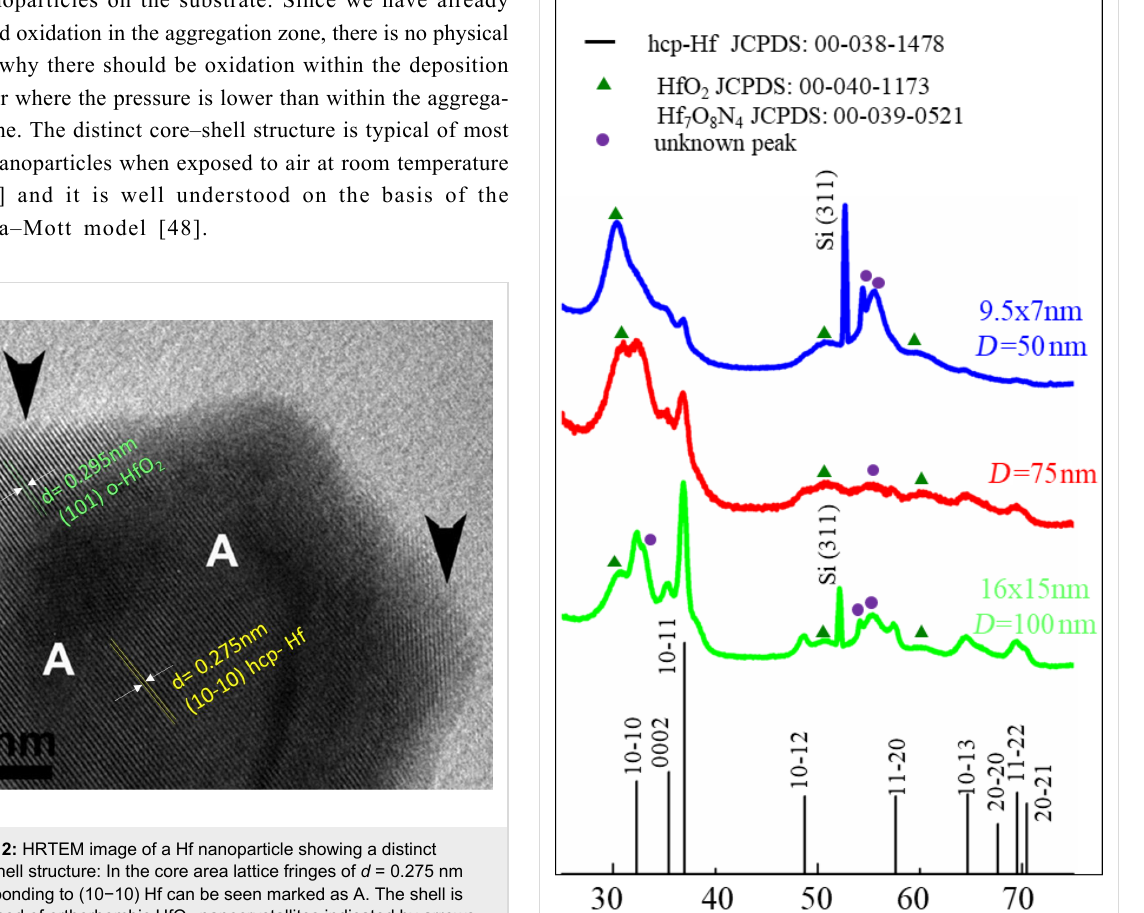
The ratio I HfO2 /I Hf of the intensities of HfO 2 at 2 θ = 30.8° and of (10 − 10) Hf at 2 θ = 36.87° is increasing with decreasing nanoparticle size. This result is due to the enhanced oxidation of smaller nanoparticles due to their higher surface-to-volume ratio. Although broadening of diffraction peaks due to the sam- ple arises from crystal size and the presence of strains and defects in the crystal [49,50], we made a simplified assumption that the X-ray peak broadening is due to the crystal size only, in order to estimate roughly the crystal grain size by applying the Scherrer equation (see Supporting Information File 1, Section 1) [49]. The size of the crystallites was calculated to be ca. 11 nm. This value is smaller than the average nanoparticle diameter defined from TEM images equal to D = 16 nm. This observation indicates that the nanoparticles are not single crys- tals, which is expected in our case, because the nanoparticles have a core–shell